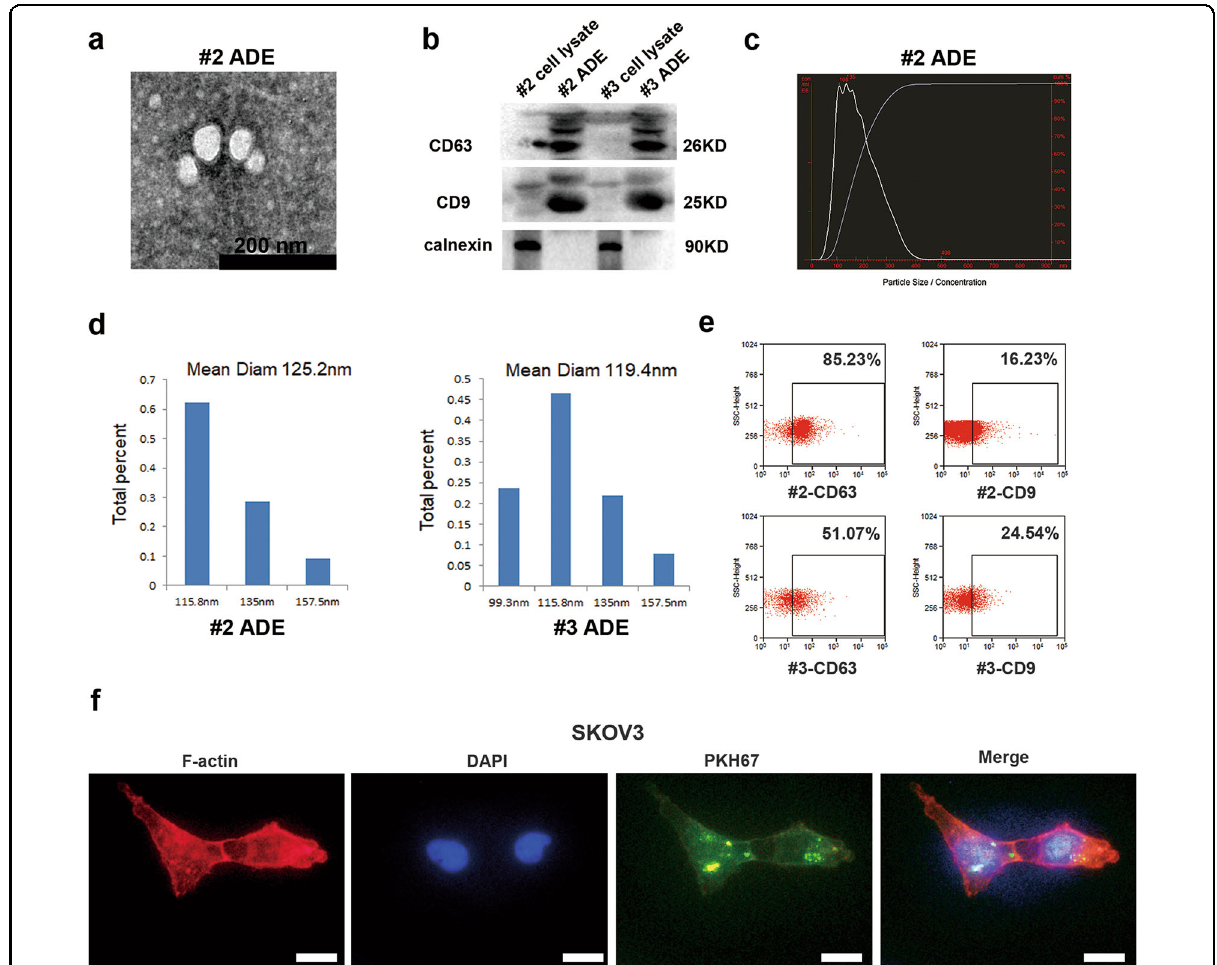
Fig. 1 ADEs enter ovarian cancer cells. a Electron micrograph of the exosomes extracted from ascites of patient #2. Scale bar, 200nm. b Western blot analysis of CD63, CD9 and calnexin in ADEs #2 and #3 as well as in the cell pellet control. c Size analysis of the ADEs #2 and #3 using NTA. d Size analysis of ADEs #2 and #3 using DLS analysis. e Flow cytometric analysis of the expression of CD63 and CD9 in ADEs #2 and #3. f Immuno fl uorescence detection of ADE uptake by SKOV3 cells. In exosomes, PKH67 was labeled with green, and F-actin was labeled red; nuclei were labeled with DAPI (blue). Scale bar, 20 μ